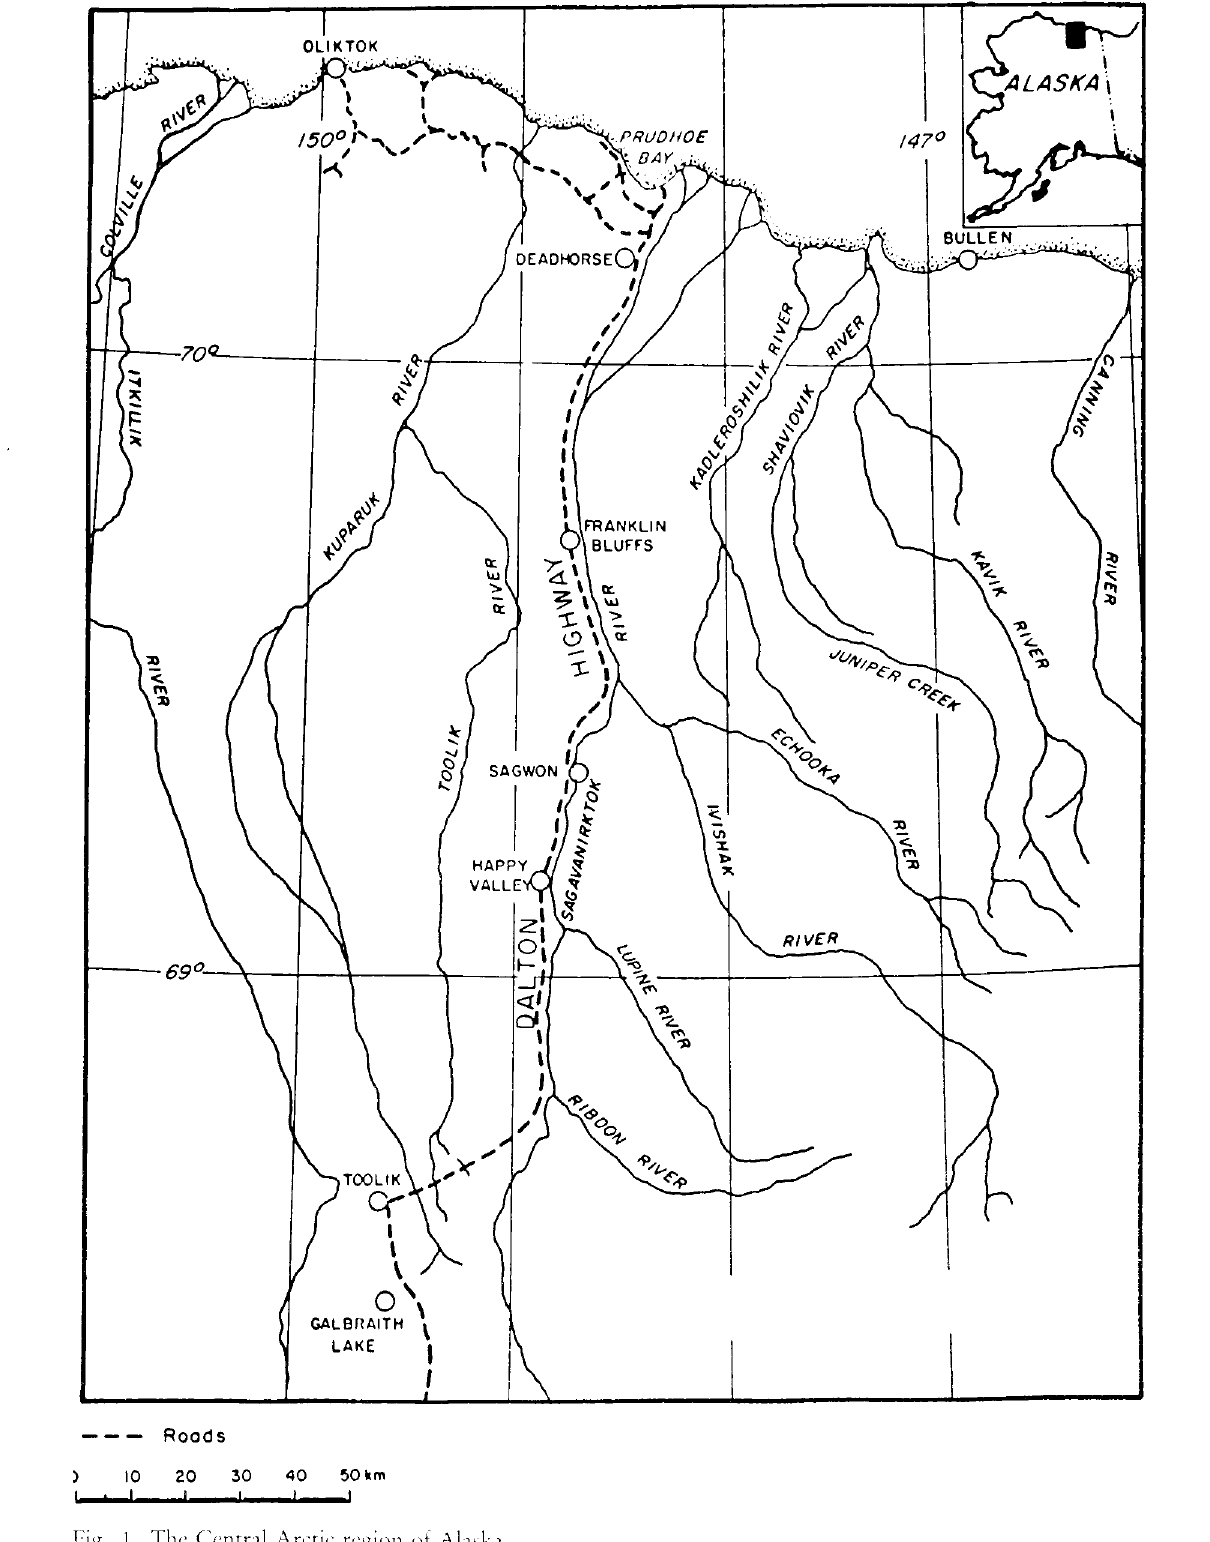
Fig. \. The Central Arctic region of